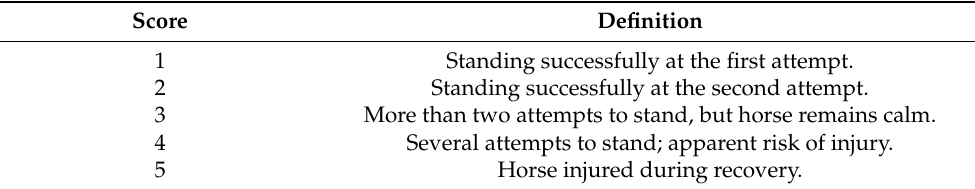
Table 1. Numerical recovery quality scoring system used for grading the recoveries following general anaesthesia under partial intravenous anaesthesia with either xylazine or medetomidine and